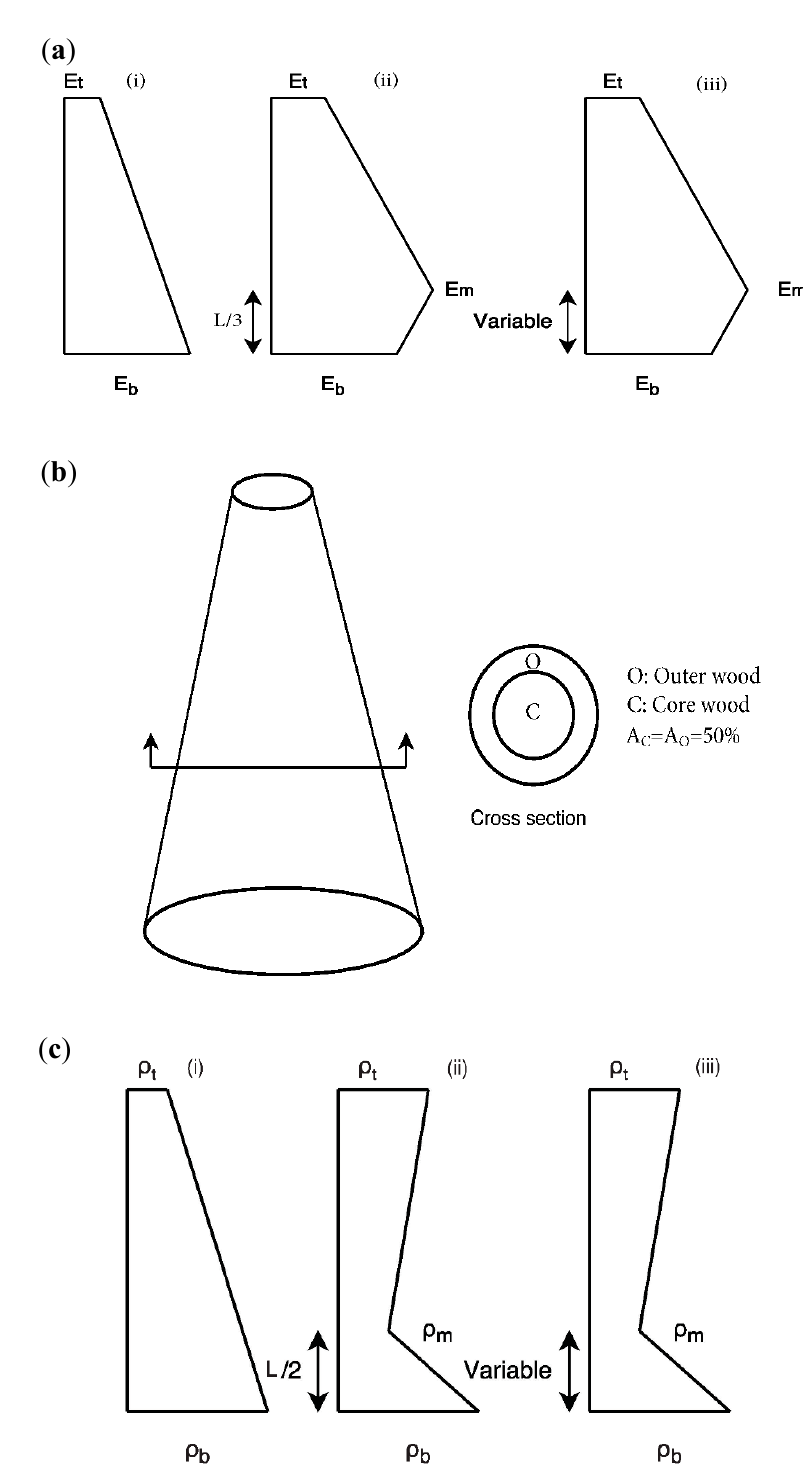
Figure 2. ( a ) Schematic of longitudinal stiffness variation scenarios (i) to (iii), ( b ) schematic of radial stiffness variation scenarios and ( c ) schematic of longitudinal density variation scenarios (i) to (iii).